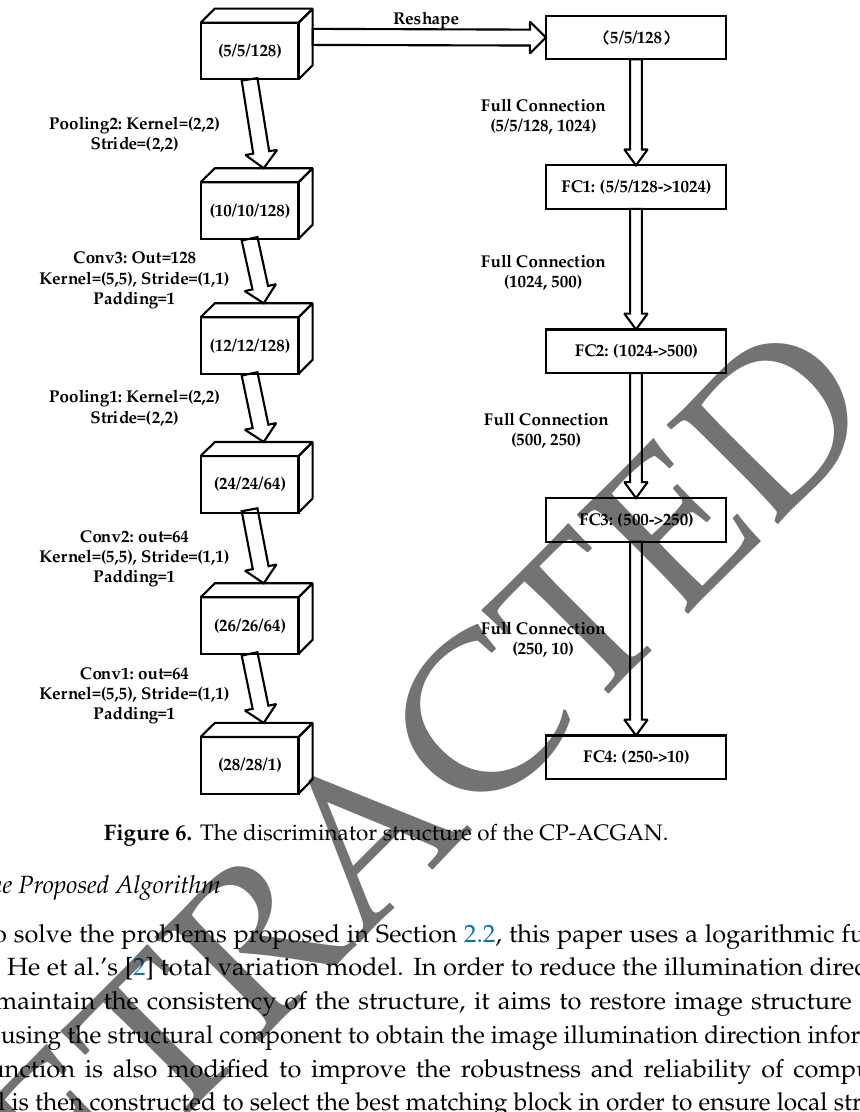
Figure 6. The discriminator structure of the CP-ACGAN.